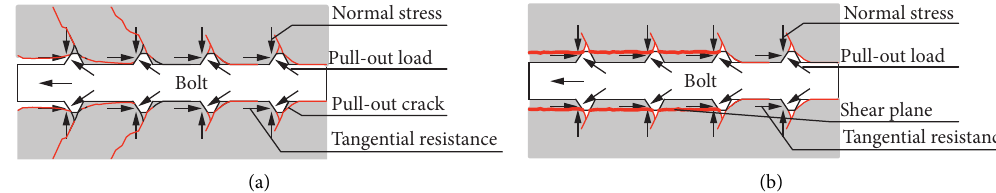
Figure 14: Failure modes of anchorage interface: (a) shear expansion slip mode; (b) shear slip